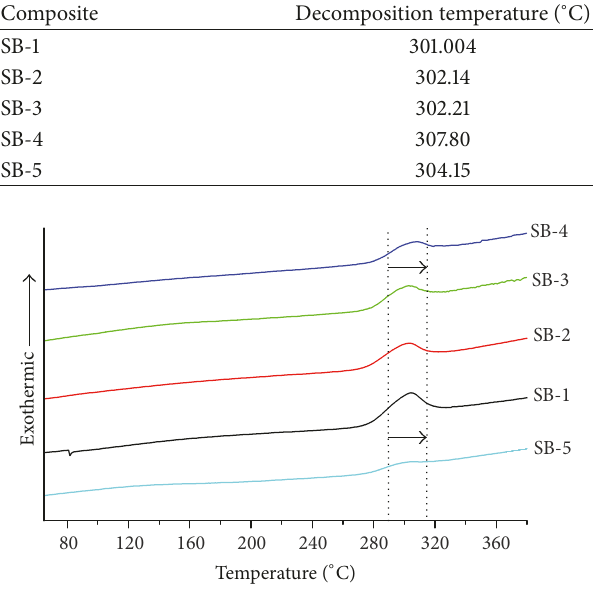
Figure 7: DSC curves of